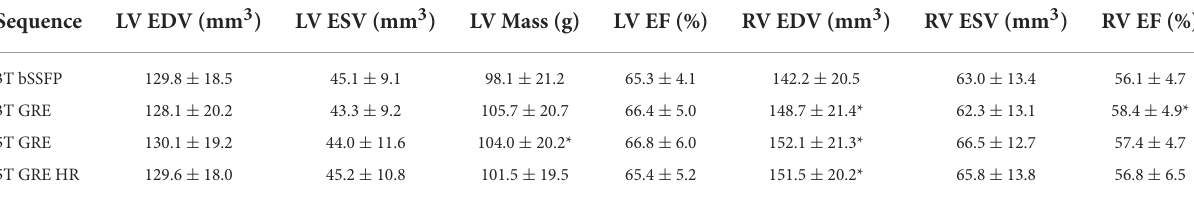
TABLE 4 Comparison of CMR CINE functional quantities, using 3T bSSFP as reference.